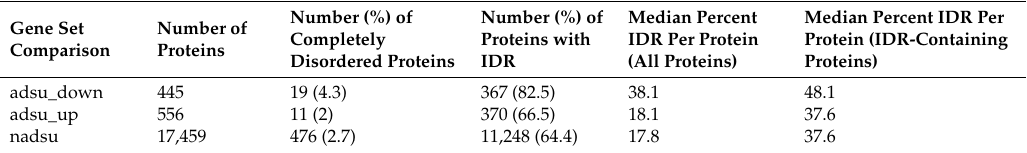
Table 3. Distribution of IDRs predicted by VSL2b in proteins encoded by genes that are differentially regulated in lymphoma cells upon interaction with stromal